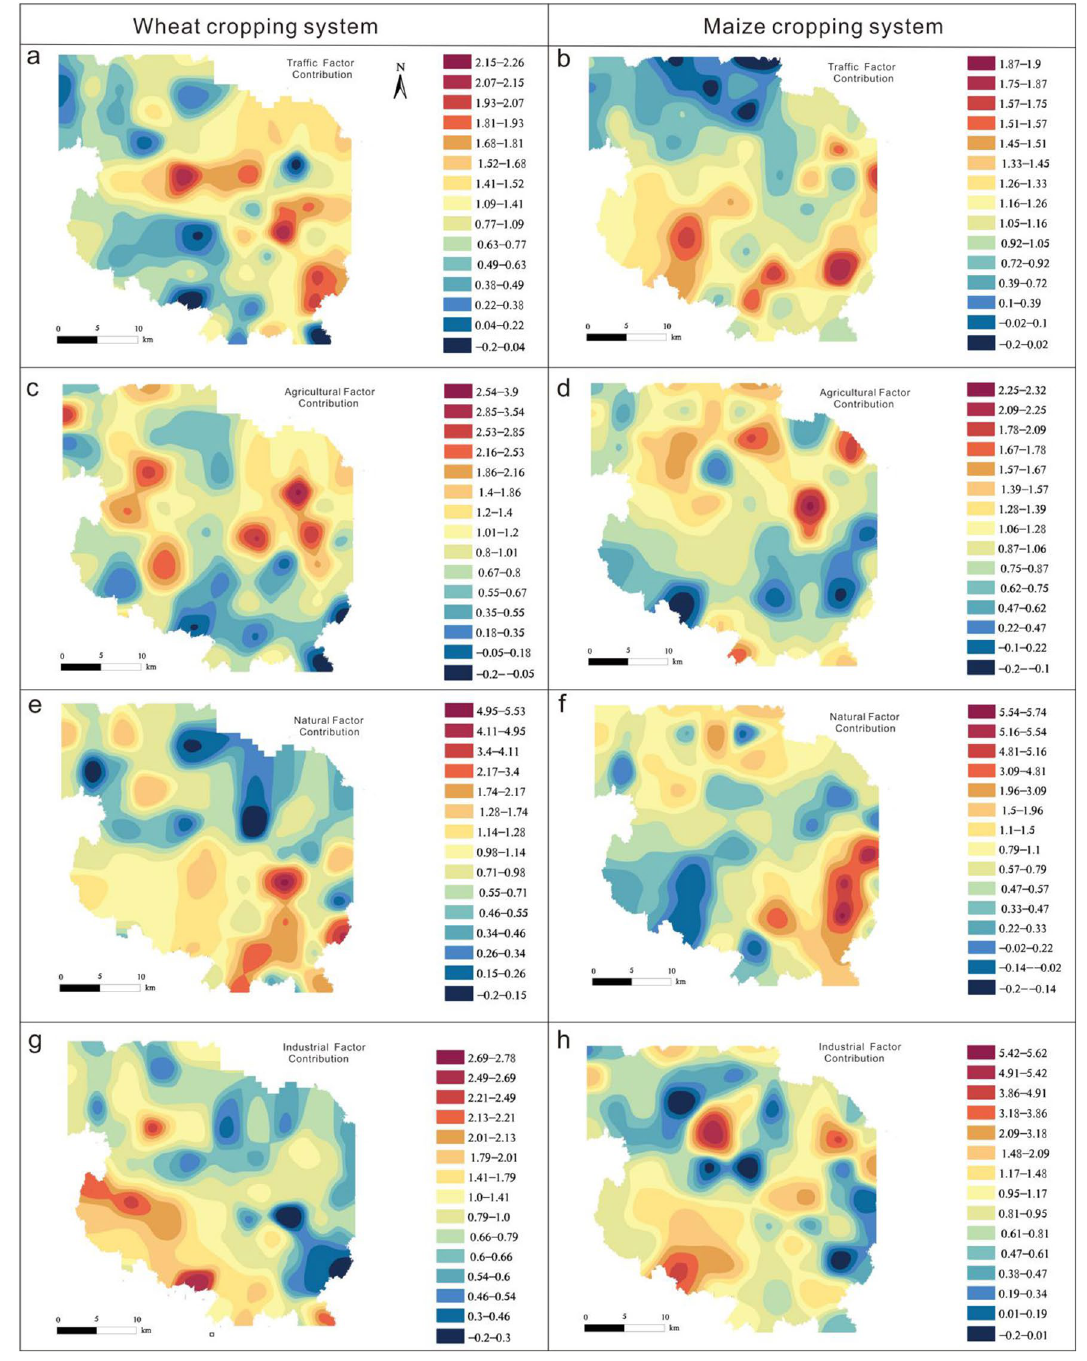
Figure 3. Spatial distribution of the normalized contributions (average of all sample sites =